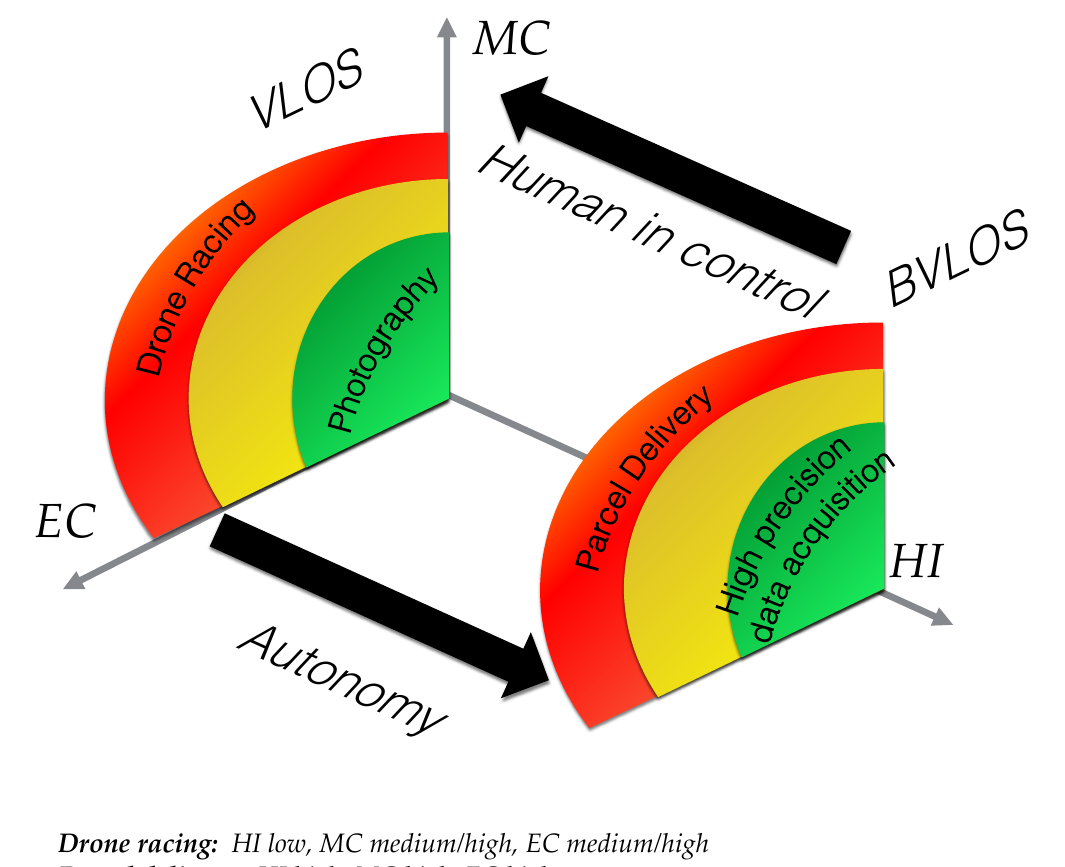
Figure 3. Several UAS applications can be mapped into the ALFUS model. Quantitative values can be assigned to each axis to convey an autonomy